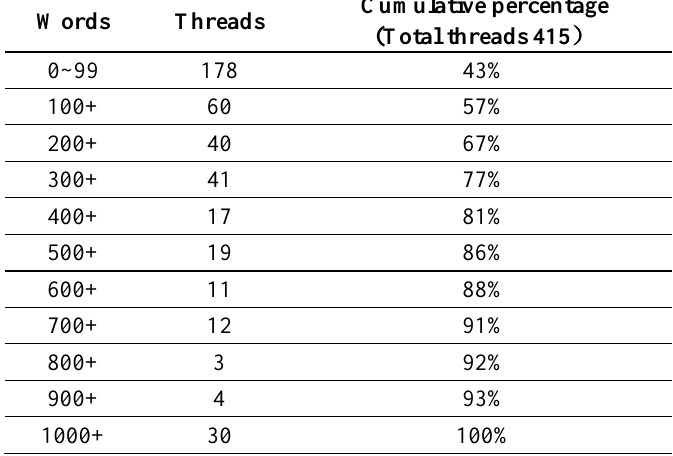
Length of threads by